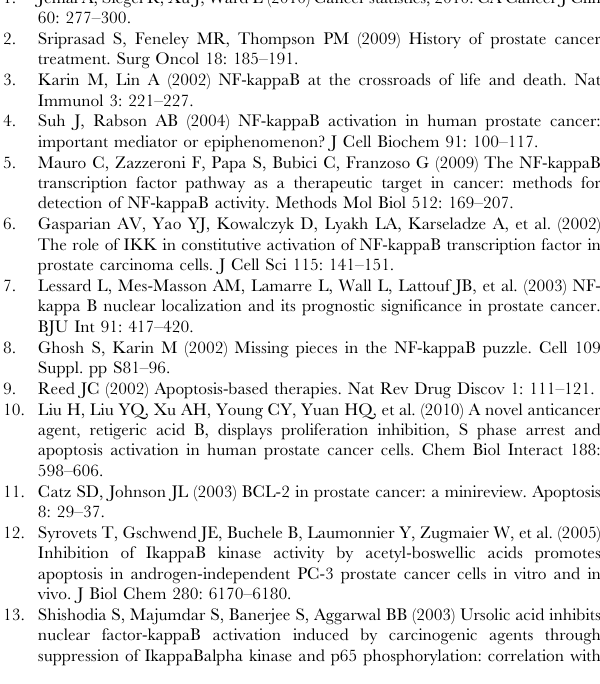
24 h. GAPDH served as the loading control. Figure S2 The validation of DNA microarray data by QRT-PCR assay. We detected the 9 mRNA expression alteration involved in PCNA, cyclin B1, p27, p21, H2AX, DDIT4, EGF, ATM and GAPDH in PC3 cells with RB-treatment for 24 h versus medium-treatment respectively, across the two different methods. Table S1 NF- k B family and NF- k B-associated genes, other cell proliferation- and survival-associated genes expression alteration p ( . =1.5-fold) in PC3 cells treated with 10 m M RB for 24 h with the DNA microarray